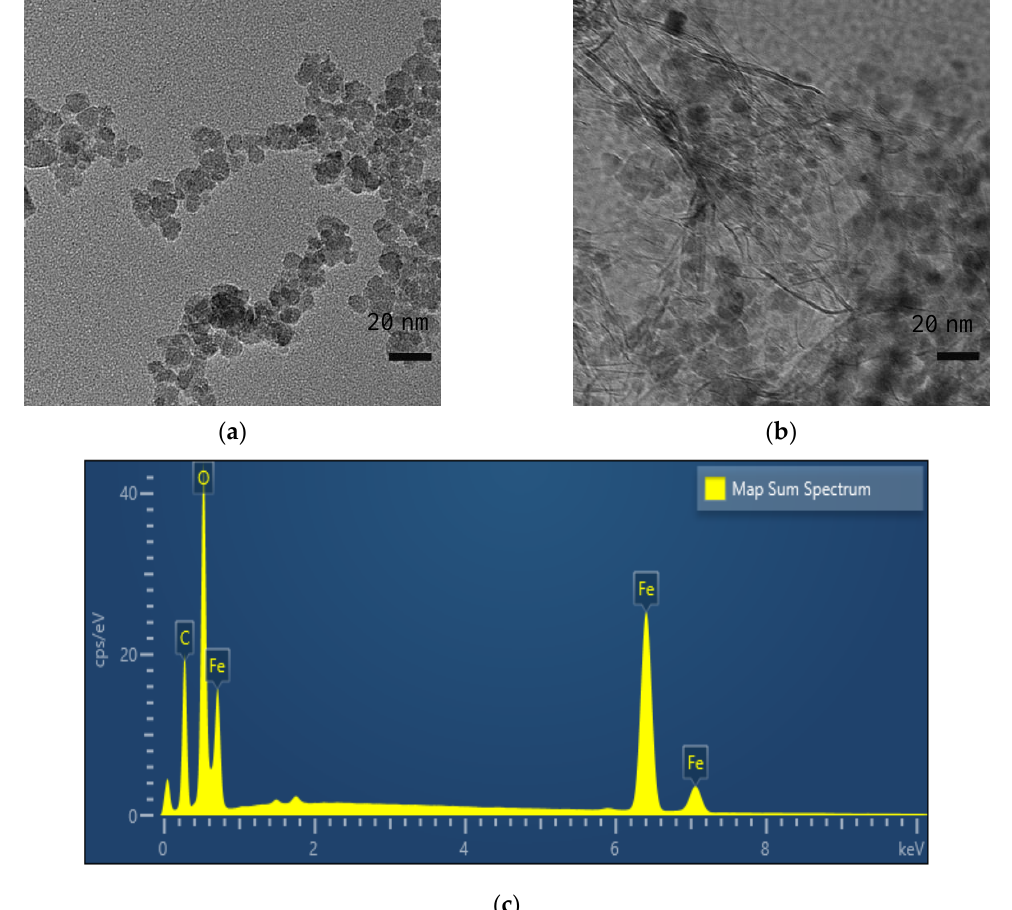
Figure 2. ( a ) TEM image of Fe 3 O 4 ; ( b ) TEM image of Fe 3 O 4 –rGO; ( c ) EDX image of Fe 3 O 4 –rGO. Raman is a non-destructive testing technique to identify the type of materials. As shown in Figure 3, under the excitation wavelength of 532 nm, three kinds of materi- als—GO, Fe 3 O 4 , and Fe 3 O 4 –rGO—were analyzed by Raman spectroscopy. The results show that GO has two characteristic peaks at 1359 nm and 1595 nm, which are attributed to the D and G bands, respectively, and the intensity ratio (ID:IG) is 0.93. In Fe 3 O 4 –rGO, the two characteristic peaks shifted to 1347 nm and 1587 nm, respectively, and the strong contrast between the D-band and G-band (ID:IG) also increased significantly to 1.4. The reason for this may be the existence of sp3 defects in the sp2 cluster during the GO re- duction process, or the increase in size of the sp2 domain due to the introduction of Fe 3 O 4 nanoparticles [22]. For Fe 3 O 4 nanoparticles, its characteristic peak exists at 695 nm, which also indicates the successful synthesis of Fe 3 O 4 nanoparticles [23].